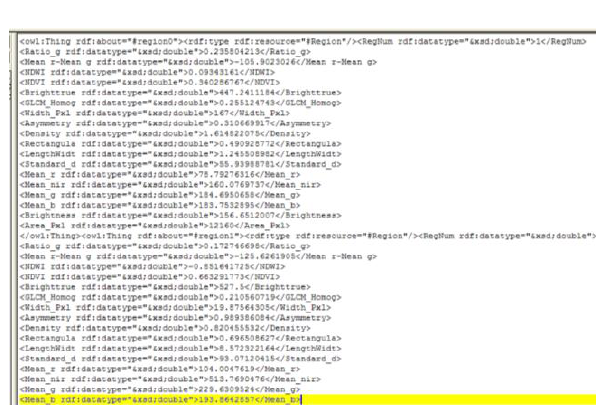
Figure 9. Feature in OWL